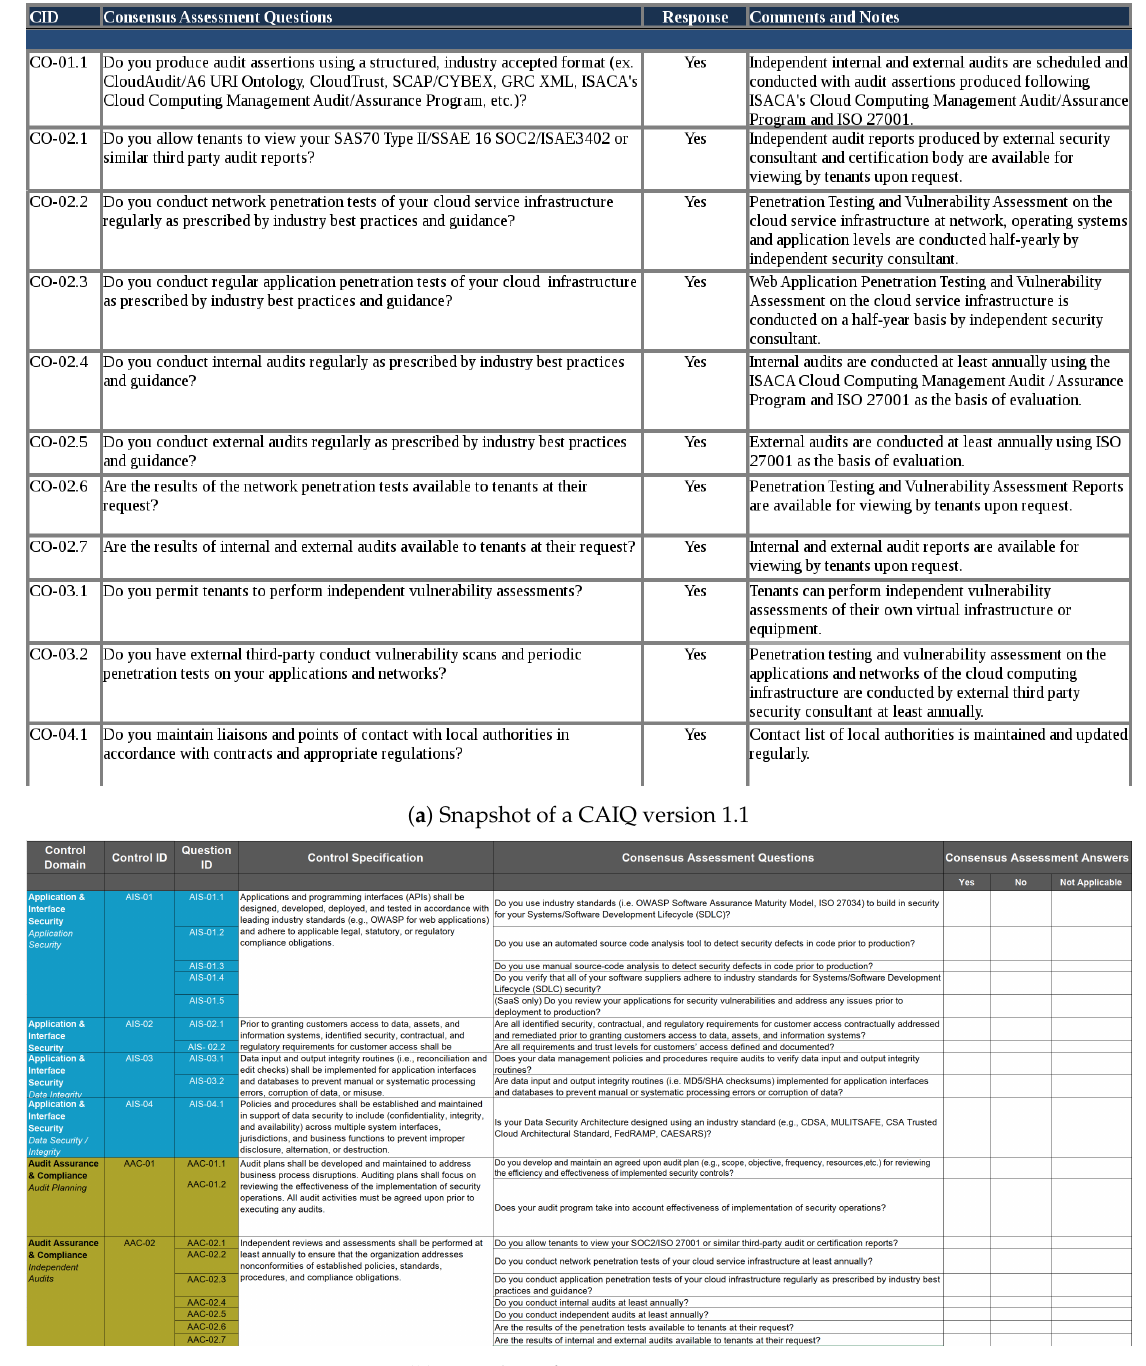
Figure 1. Consensus Assessments Initiative Questionnaire (CAIQ)